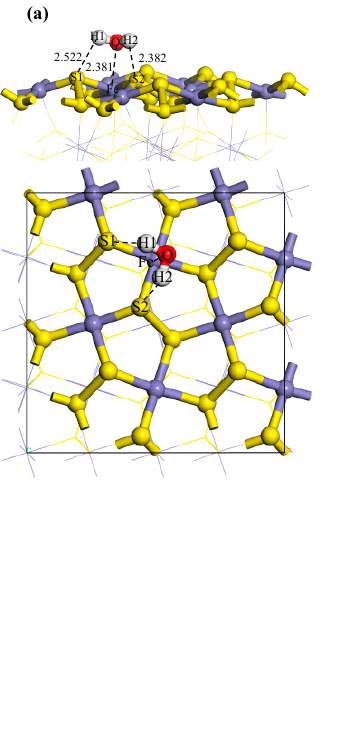
Molecules 2019 , 24 , x 4 of 11 Figure 1. The initial ( a ) and equilibrium ( b ) adsorption models of one carbon atom on the coal pyrite surface for ( 1 ) F; ( 2 ) HPS; ( 3 ) LPS; ( 4 ) FS; and ( 5 ) F-4C.